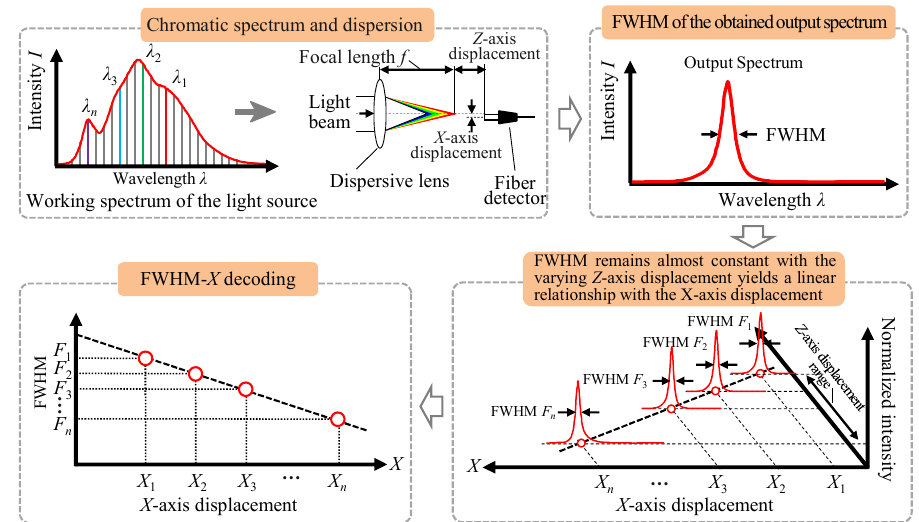
Figure 3. A flowchart of the measurement principle and the corresponding decoding process of the proposed fiber-based chromatic dispersion probe for the displacement measurement of the X -axis. Figure 4 shows a flowchart of the measurement principle and the corresponding de- coding process of the proposed fiber-based chromatic dispersion probe for displacement measurement of the Z -axis. Additionally, with the detected output spectrum, the centroid wavelength λ can be obtained. Thus, decoding the linear relationship between the cen- troid wavelength λ and Z -axis displacement in different X -axis displacements can be per- formed, in which different sensitivity S ( λ-Z curve slopes) can be observed. With the dif- ferent sensitivity S ( λ-Z curve slopes), the linear relationship between the sensitivity S and X -axis displacement can also be inspected within a specific X -axis displacement range.